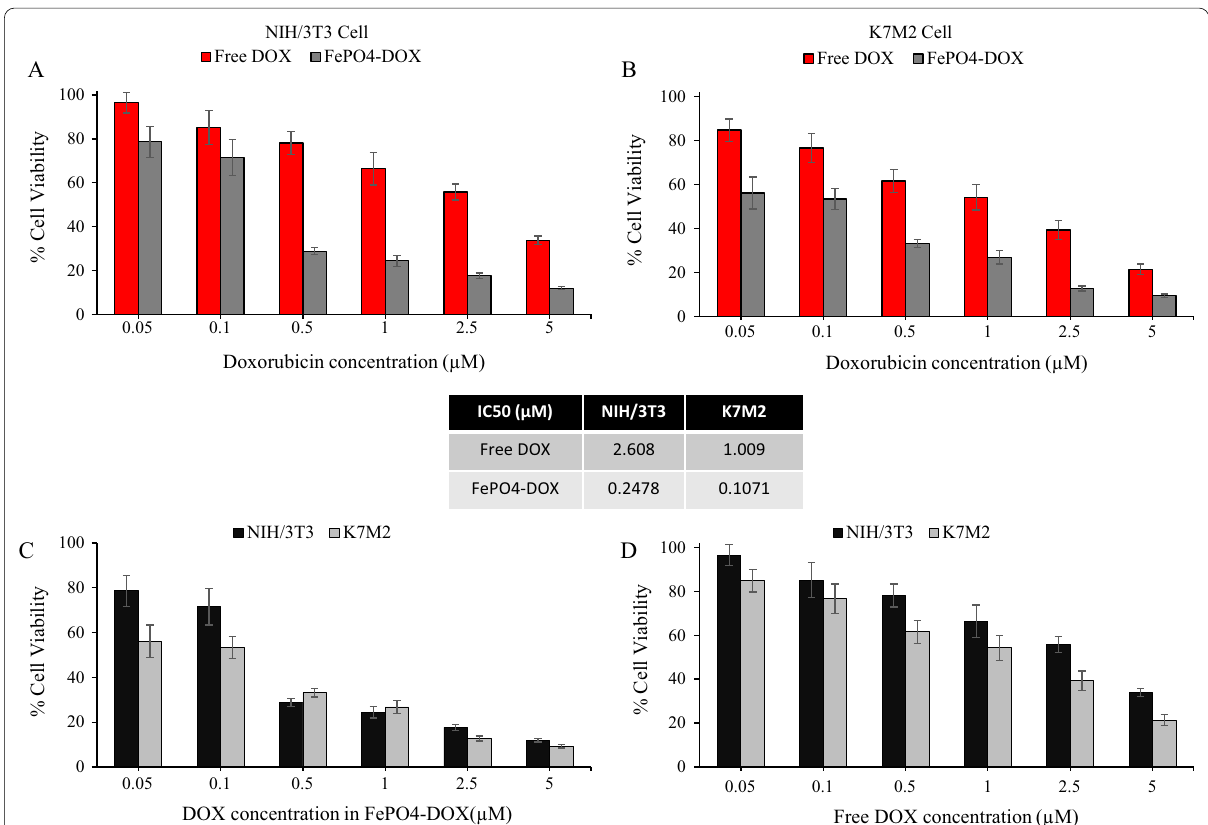
Fig. 3 Cytotoxicity of FePO 4 -DOX NPs. a, b Cytotoxicity of Free Doxorubicin (DOX) and FePO 4 -DOX NPs in mouse fibroblast NIH/3T3 and osteosarcoma K7M2 cell-line, respectively, at various DOX equivalent concentration. Cytotoxicity was analyzed in percentage cell viability after particle treatment for 48 h. c, d A comparison in percentage cell viability of FePO 4 -DOX NPs and Free DOX in NIH/3T3 and K7M2 cell lines, respectively, at equivalent DOX concentration. The inset in the middle represents the IC-50 values of Free DOX and FePO 4 -DOX NPs in NIH/3T3 and K7M2 cells (data represents mean s.d.; n 6 ± =